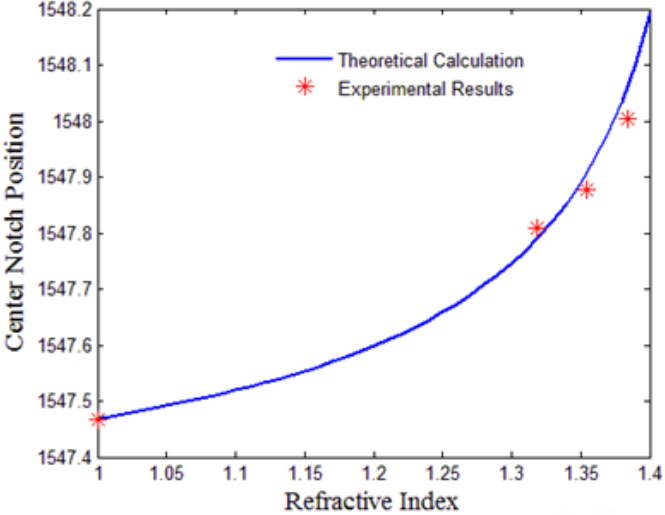
Figure 4. Experimental and simulated spectral notch position as a function of the RI of ambient material.